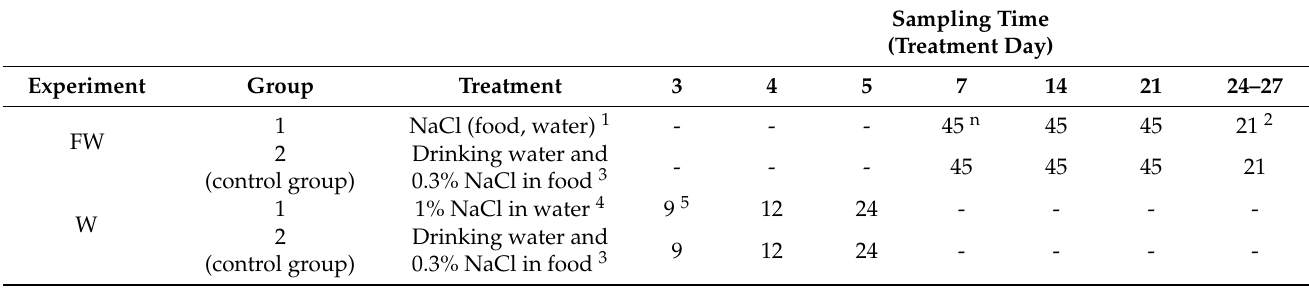
Table 1. Number of birds, treatments, treatment day (td) and treatment sampling times Leghorn